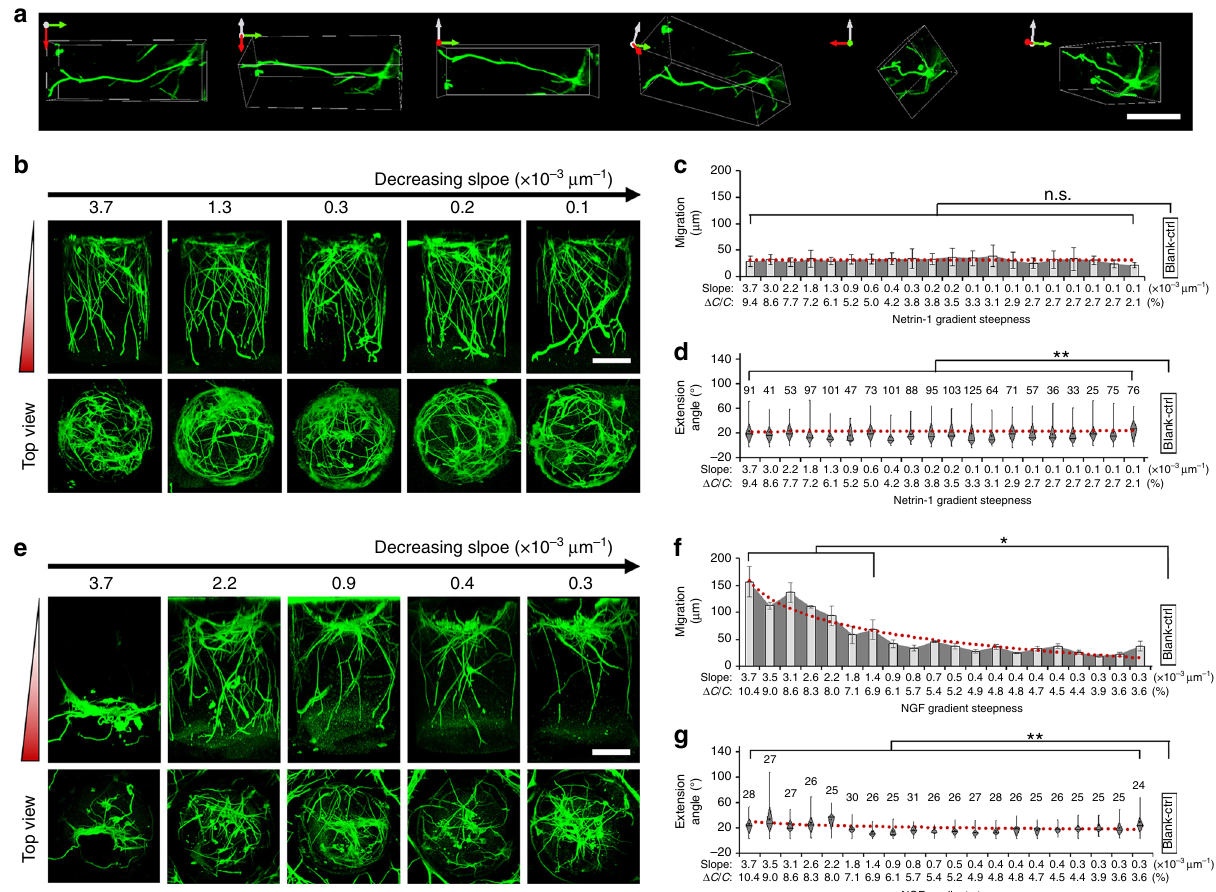
Fig. 3 Neuronal response to netrin-1 or NGF gradient of varied steepness. a β III-tubulin fl uorescence image of different angles showing the 3D morphology of a single neuron cultured in a hydrogel cylinder, scale bar, 100 µ m. b Side and top views of 3D cultured hippocampal neurons ( β III-tubulin) in response to netrin-1 gradient of different steepness, scale bar, 100 µ m. c Quantitative analysis of neuronal migration and related association with netrin-1 gradient steepness, n = 4, error bars indicate the standard deviation. d Box-plots for quantitative analysis of neurite guidance in response to varied netrin-1 gradient steepness, more than 25 neurites were pooled from four biological replicates. e Side and top views of 3D cultured neurons ( β III-tubulin) in response to the NGF gradient of varied steepness, scale bar, 100 µ m. f Quantitative analysis of neuronal migration and related association with NGF gradient steepness, n = 4, error bars indicate the standard deviation. g Box plots for quantitative analysis of neurite guidance in response to varied NGF gradient steepness, more than 20 neurites (as indicated on top of each box) were pooled from four biological replicates. For d , g , the parts of the box indicate 25, 50 and 75 percentiles, and the whiskers indicate 5% and 95%. The square mark indicates mean of the data. For c , d , f , g , the red line indicates a logarithmic fi tting of the mean. The neuronal growth pattern in each hydrogel cylinder was compared in pairwise to experiments with exactly the same con fi gurations but without any chemotactic factor treatment (Blank-ctrl, Supplementary Fig. 6), * or **indicates a p -value <0.05 or <0.005 by paired Kruskal – Wallis